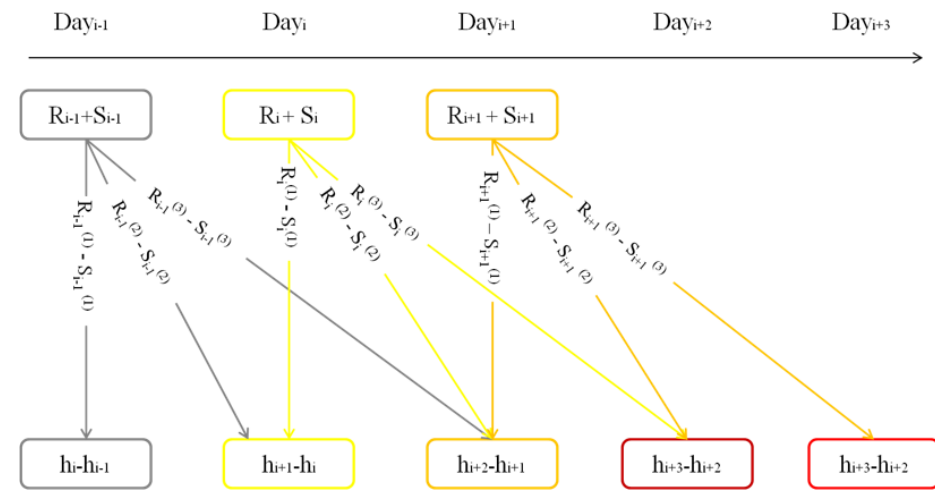
Figure 6. Schematic diagram of water infiltration from the surface to the groundwater table for a time lag 2 of 2 days.